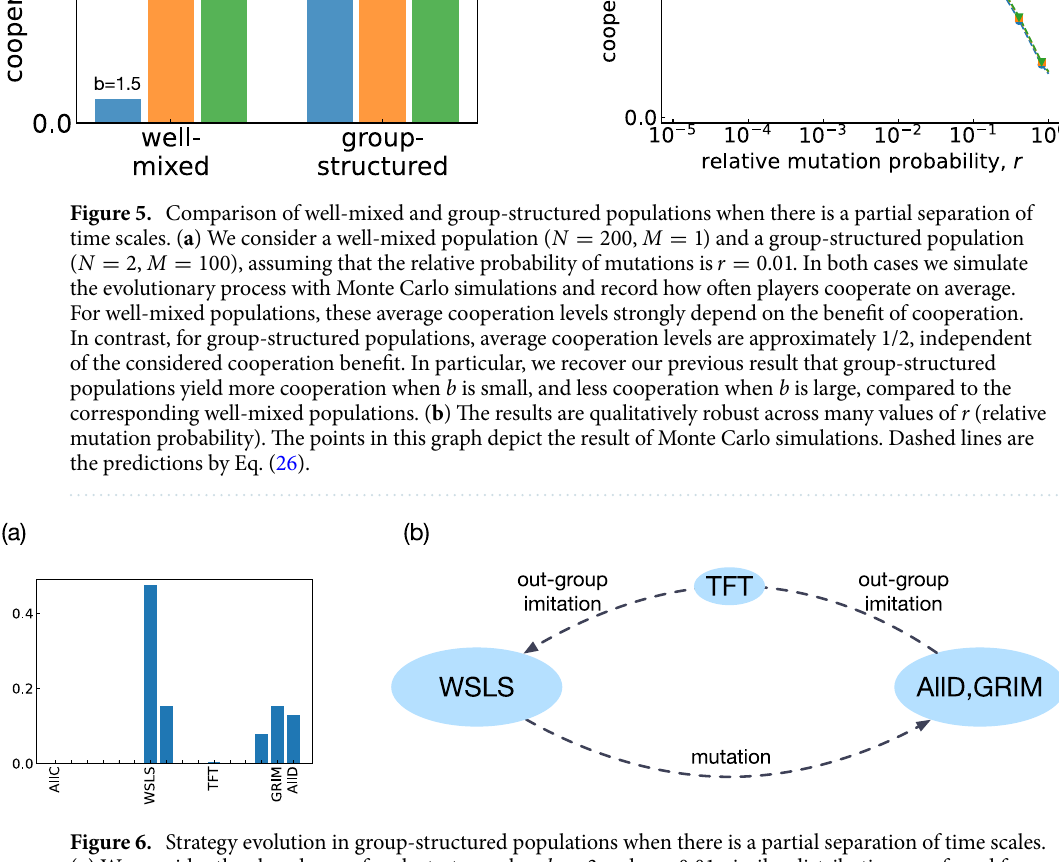
Figure 6. Strategy evolution in group-structured populations when there is a partial separation of time scales. ( a ) We consider the abundance of each strategy when b = 3 and r = 0.01 ; similar distributions are found for other parameters when r (cid:31) O ( 10 − 1 ) . WSLS is most abundant, followed by S 7 , Grim, AllD, and S 13 . ( b ) A schematic diagram of the typical transitions between strategies reveals that groups of AllD and Grim players tend to transition towards TFT by out-group imitation. TFT groups in turn tend to transition towards more cooperative strategies like WSLS or AllC. Finally, WSLS groups tend to transition towards AllD and Grim once these strategies are introduced by WSLS groups are comparably stable; as they reach the maximum payoff against themselves, individuals in these groups are unlikely to learn non-cooperative strategies by out-group imitation. However, strategies like AllD and Grim may invade a group of WSLS players once they are introduced by mutations. Assuming that the group is small (the figure depicts the case of N = 2 ), AllD and Grim are both likely to take over, thereby closing the evolutionary cycle. Importantly, the above arguments do not depend on the precise value of b ; they only depend on the win-lose relationships between strategies. This argument can thus explain why we observe a coexistence between WSLS and non-cooperative strategies for a wide range of benefit values. The above argument also explains the dependency of cooperation levels on r . When r is sufficiently small, the abundance of TFT also becomes as small as O ( r ): the transitions between WSLS and the defectors thus balance, and their abundance as well as cooperation levels do not show significant change as r varies. However, because the flow from WSLS to the defectors are mainly driven by the mutation events, the abundance of WSLS players drops as mutation events get more frequent. When r or M is even smaller, evolutionary results become closer to the results observed when there is a complete separation of time scales. The crossover point depends on the strength of selection. When selection strengths are sufficiently weak, the evolutionary dynamics get closer to neutral selection, where fixation times are relatively short. Here, either WSLS or AllD may happen to take over the entire population with a non-negligible frequency, and the evolutionary dynamics are better described by the complete separation of time scale.